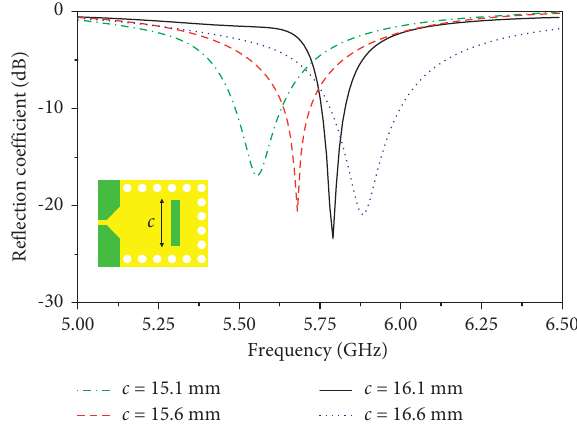
Figure 10: Parametric study for the length of the SIW cavity slot antenna.